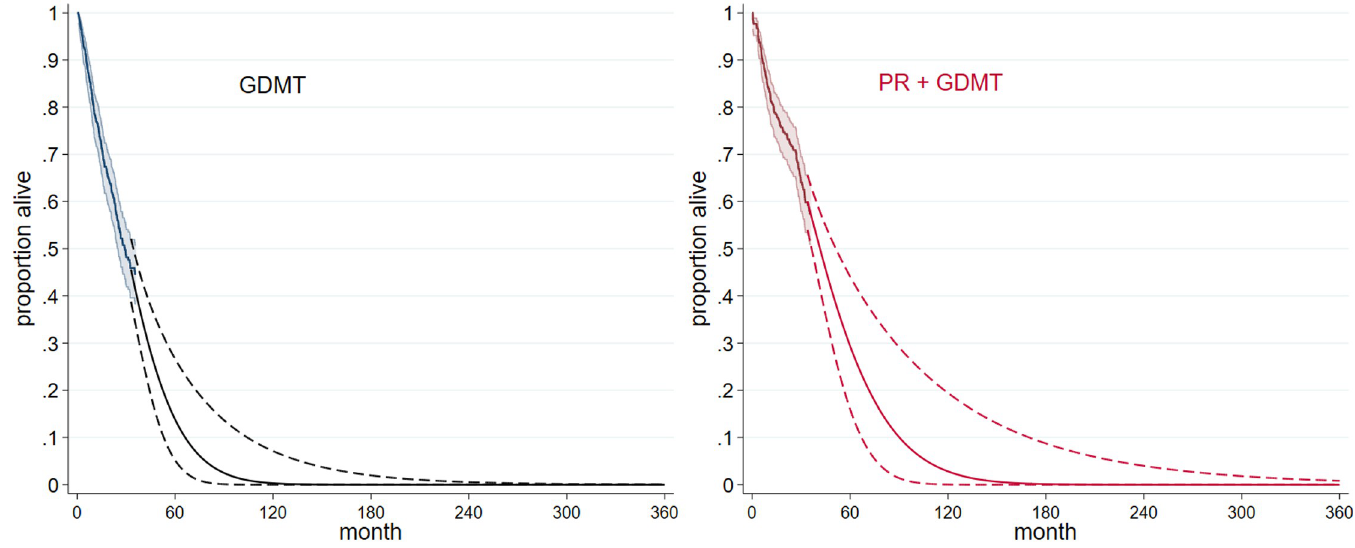
Fig 4. Flexible parametric survival models with 95% CIs used in the current cost-effectiveness analysis.